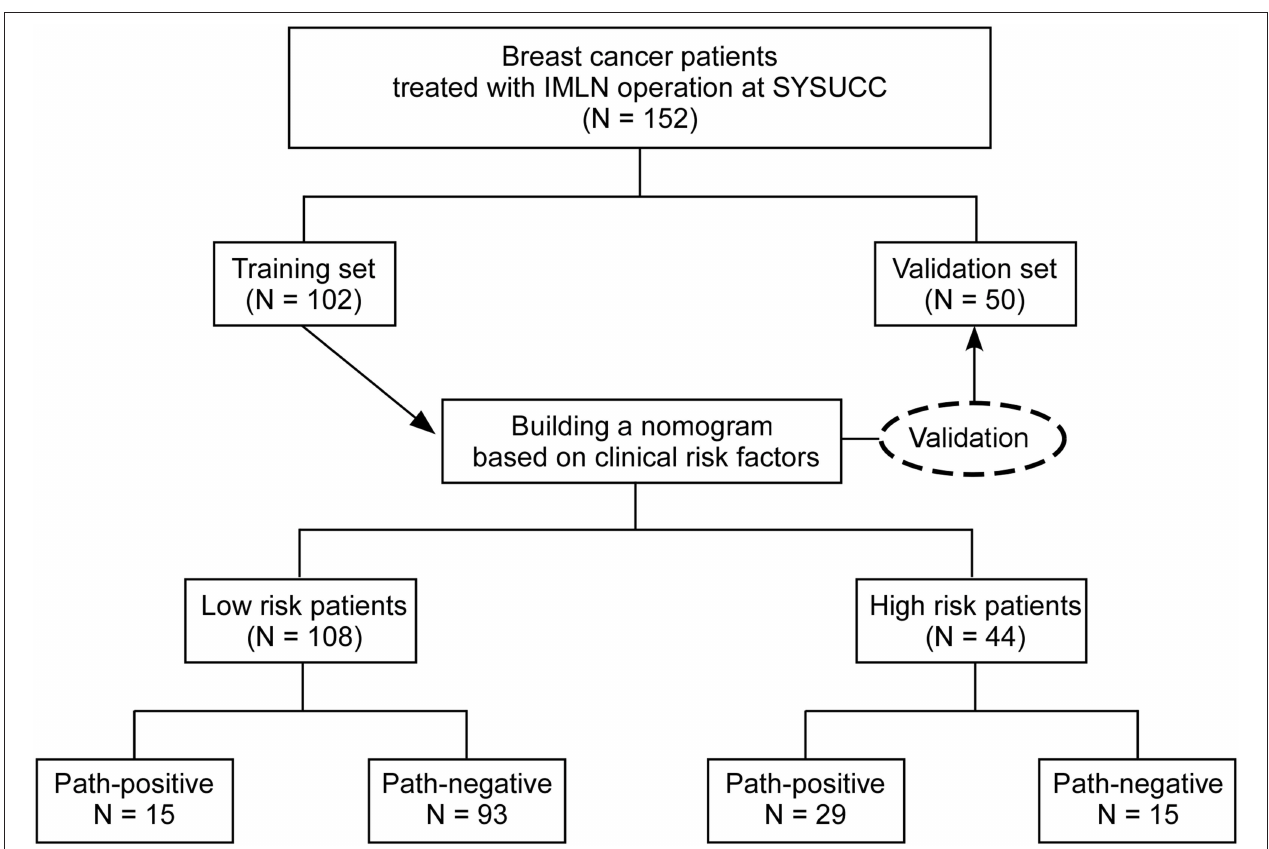
FIGURE 1 | Schematic results of constructed nomogram and final IMLN